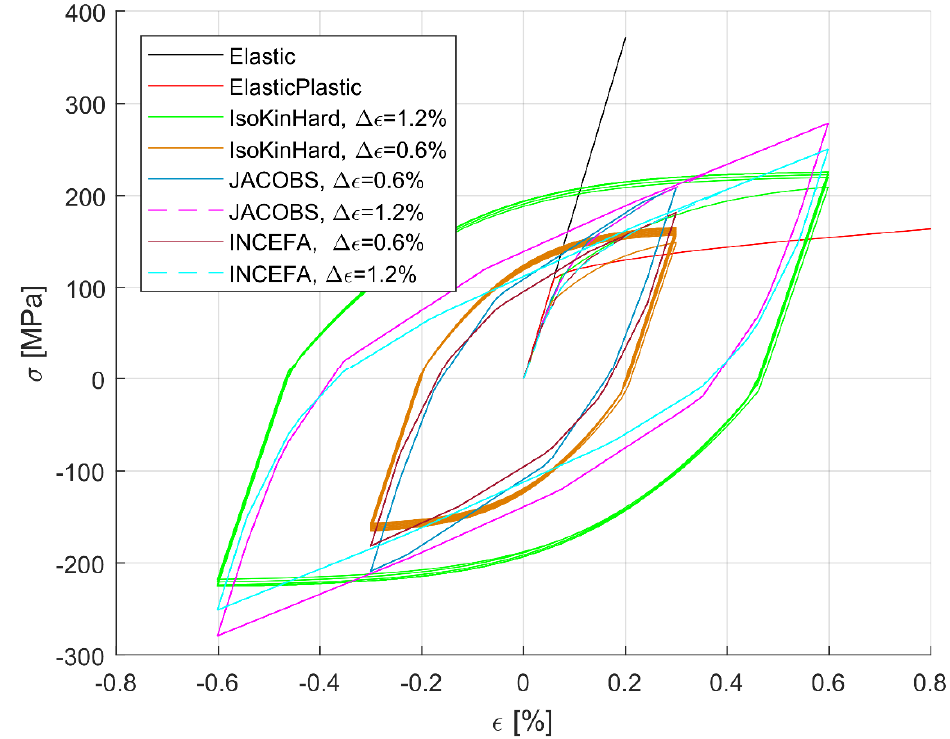
Figure 4. AISI 304L material models, used for FEM models [22].